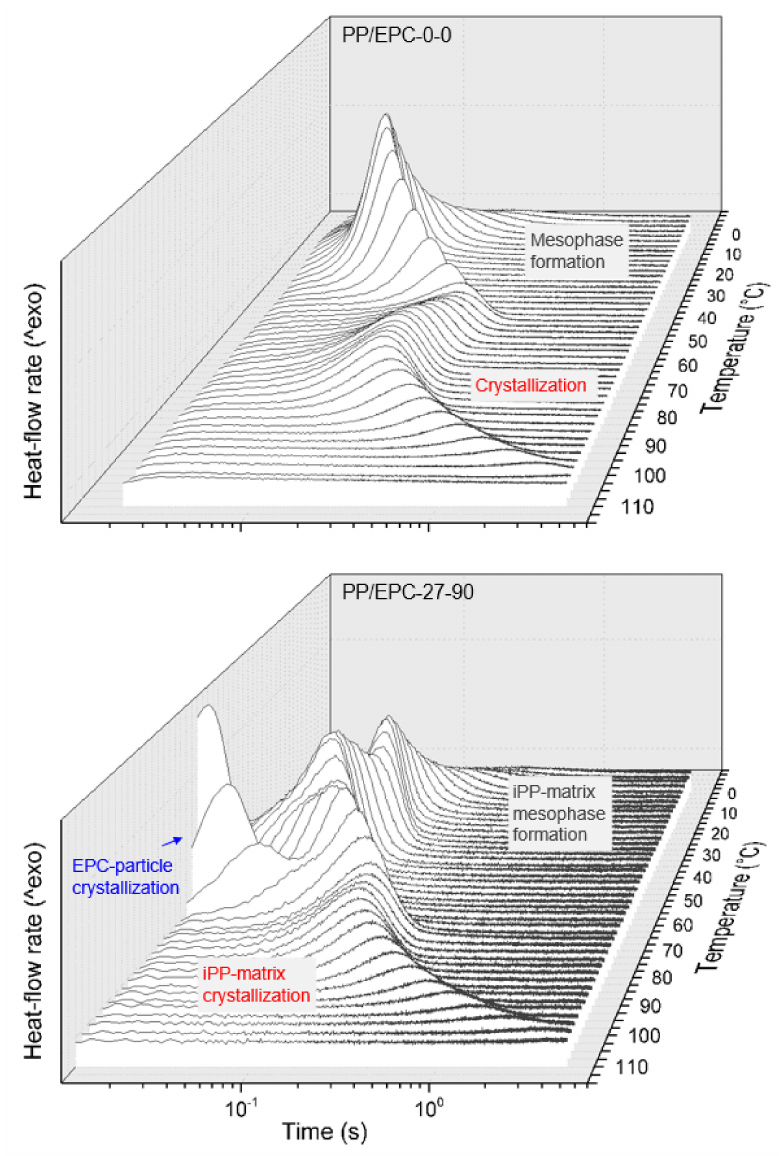
Figure 5. Sets of FSC crystallization isotherms of the samples PP / EPC-0-0 (neat iPP, top) and PP / EPC-27-90 (heterophasic iPP, bottom). Exothermic heat-flow rate is directed upwards and color coding of labels is in analogy to above